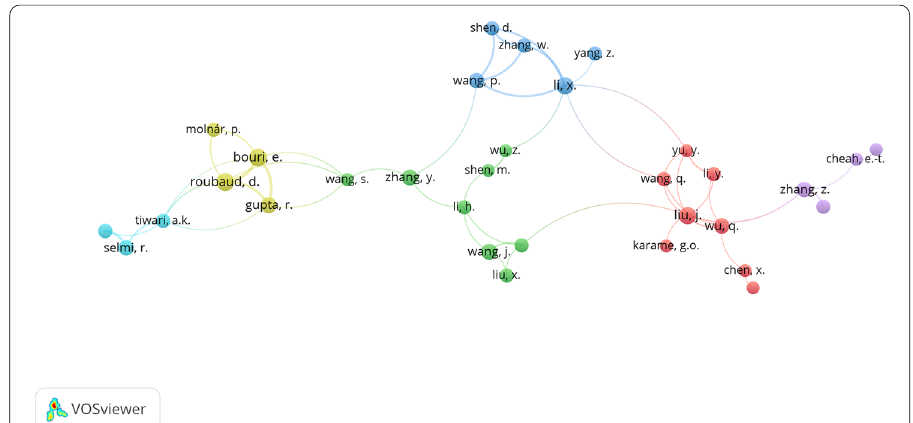
Fig. 8 Author cluster on Scopus. Source : Own compilation